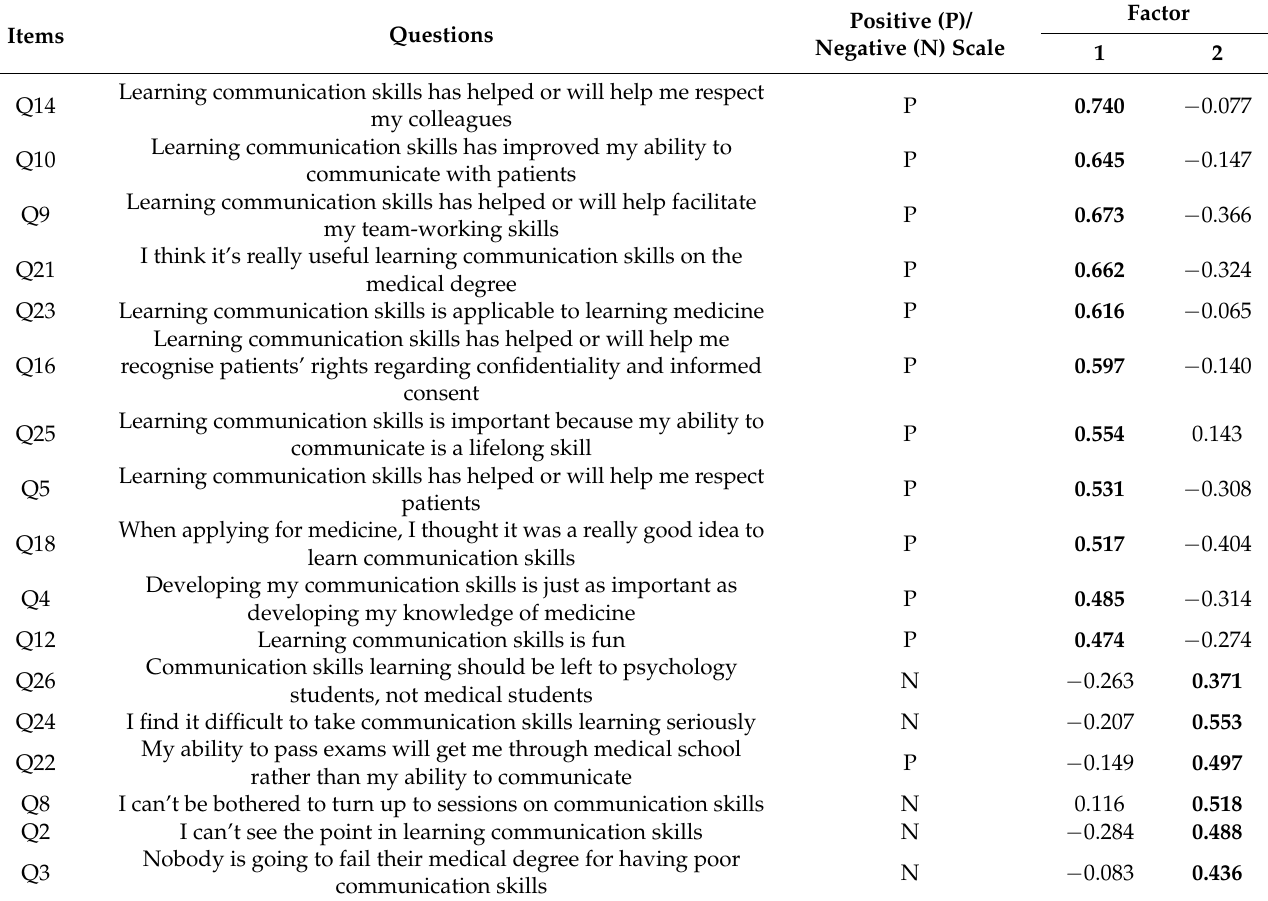
Table 2. Final rotated pattern matrix with 23 items (Q15 and Q1